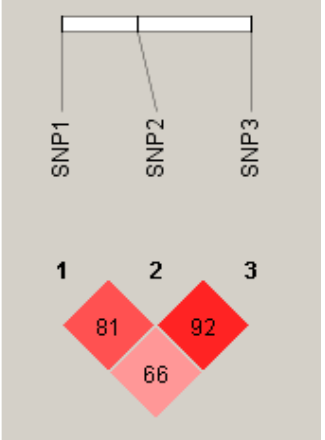
Figure 2. Haploblock structures of the 5′flanking and exon 1 region as revealed by Haploview